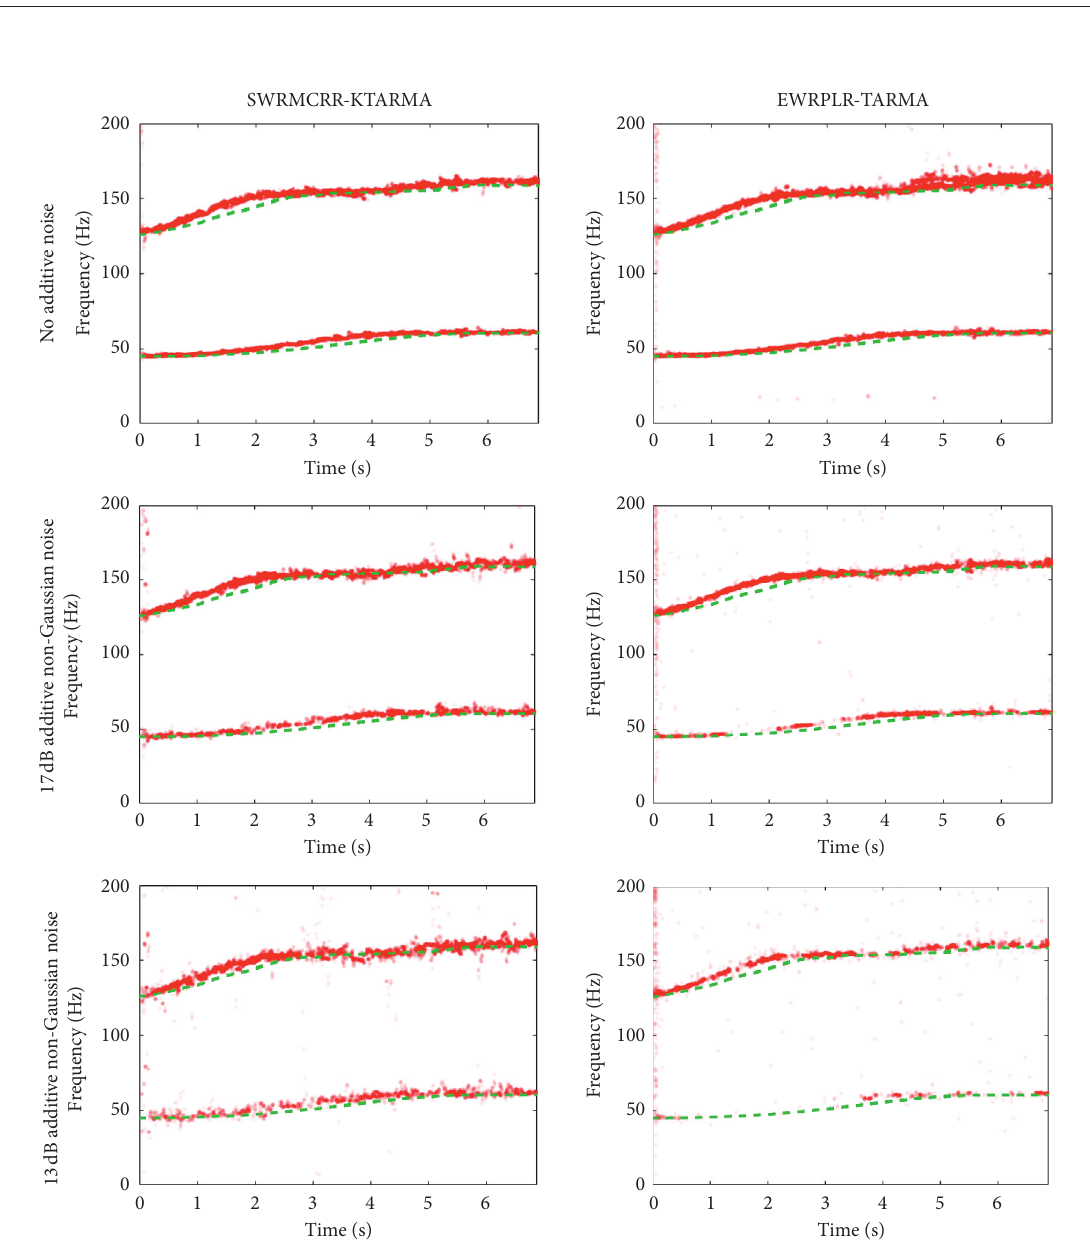
Figure 6: Modal frequencies estimated by SWRMCRR-KTARMA and EWRPLR-TARMA (green lines: baseline values; red dots: modal frequency estimates of all 10 Monte Carlo runs).